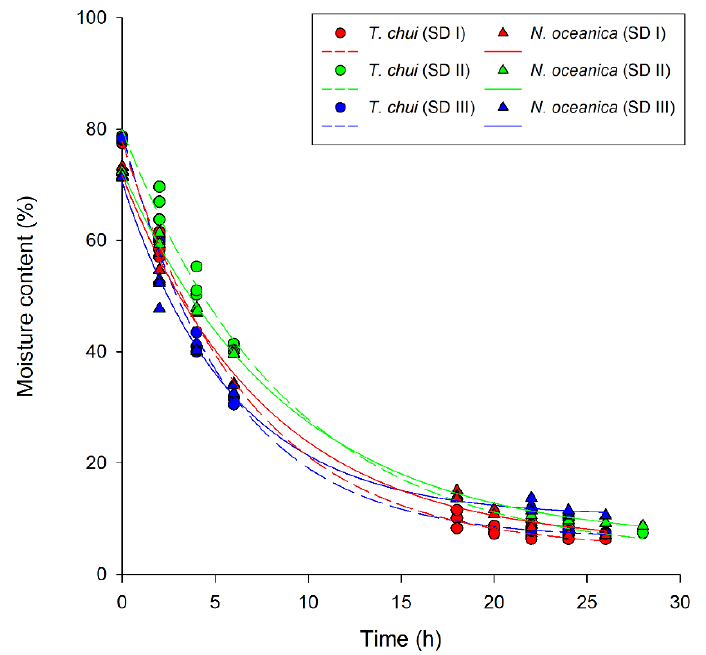
Figure 3. Relative moisture loss of solar-dried Tetraselmis chui (circles and dashed lines) and Nannochloropsis oceanica (triangles and solid lines) biomass during three independent drying trials (SD I, II, and III).